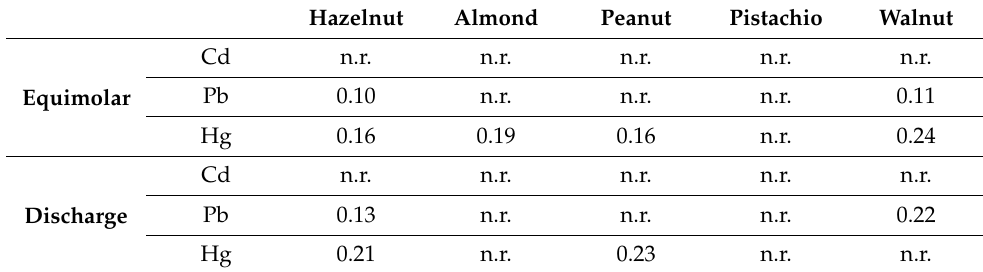
Table 4. Differences ( ∆ ) in removal efficiency based on pre-treatment (100 ◦ C and 22 ◦ C) for the different elements (cadmium (Cd), lead (Pb) and mercury (Hg) and biosorbents (Hazelnut, Al- mond, Peanut, Pistachio and Walnut), for the two contamination scenarios studied (Equimolar and Discharge). Hazelnut Almond Peanut Pistachio Walnut Cd n.r. Equimolar